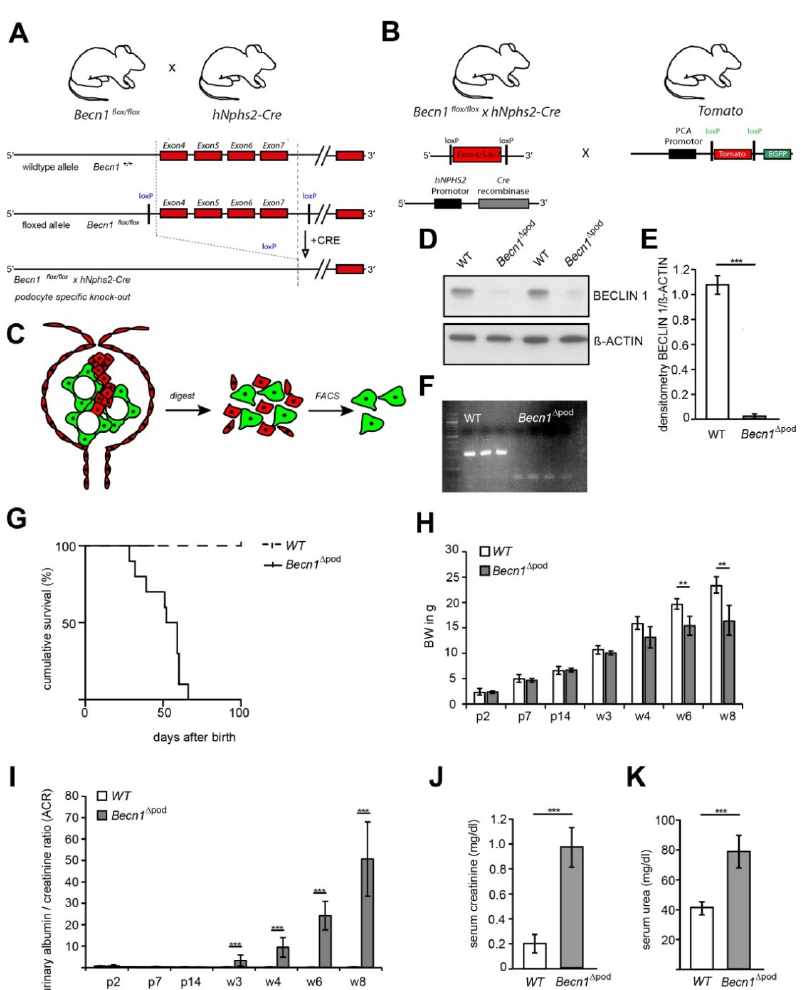
Figure 1. Podocyte-specific knockout of Becn1 expression. ( A ) Schematic showing the generation of Becn1 ∆ pod mice by crossing Becn1 flox/flox mice with hNphs2-Cre mice; ( B ) Schematic showing the generation of fluorescence-labelled podocytes by crossing Becn1 flox/flox × hNphs2-Cre mice with Tomato/EGFP reporter mice; ( C ) Schematic showing the ex vivo isolation of podocytes after glomeruli isolation, digestion and mechanical shearing and subsequent fluorescence-activated cell sorting (FACS); ( D ) Western blotting was performed to determine the abundance of BECLIN1 in ex vivo isolated primary podocytes; ( E ) Densitometry data obtained from samples shown in ( D ) (*** ≤ 0.001); ( F ) PCR was performed to identify Becn1 deletion using a DNA template obtained from isolated Becn1 ∆ pod and WT podocytes. ( G ) Survival analysis of Becn1 ∆ pod and WT mice (n = 30 each genotype); ( H ) Body weight of Becn1 ∆ pod and WT mice through week 8 (** ≤ 0.01); ( I ) Urinary albumin/creatinine ratio in Becn1 ∆ pod and WT mice through week 8 (** ≤ 0.01 and *** ≤ 0.001, respectively); ( J ) Serum creatinine (mg/dL) in WT and Becn1 ∆ pod mice *** ≤ 0.001); ( K ) Serum urea (mg/dL) in WT and Becn1 ∆ pod mice (*** ≤